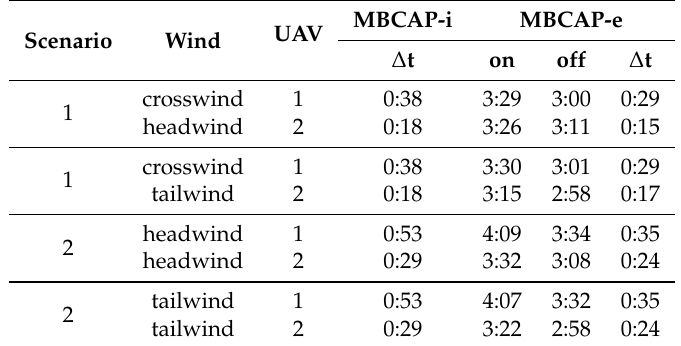
Table 2. MBCAP flight time overhead (min:s) vs.